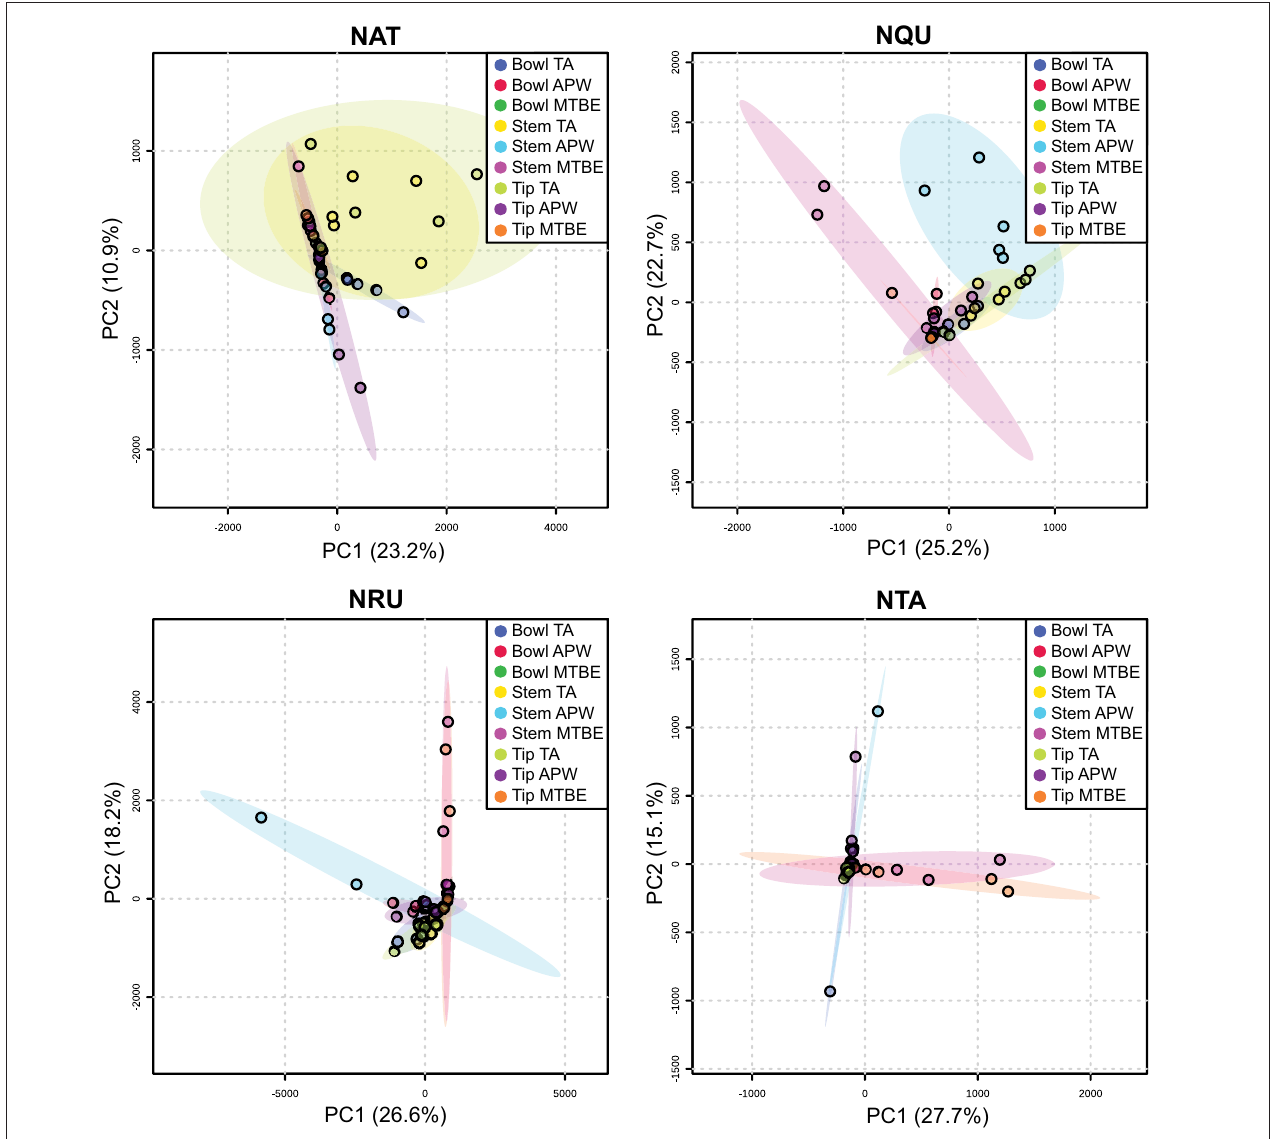
FIGURE 5 | Principal component analysis (PCA) of experimental pipes by section (i.e., bowl, stem, and tip) smoked with N. attenuata ( NAT ), N. quadrivalvis ( NQU ), N. rustica ( NRU ), and N. tabacum ( NTA ). TA, APW, and MTBE correspond to 2% aqueous tartaric acid, acetonitrile:2-propanol:water [3:2:2], and methyl tert -butyl ether, respectively. Each point within the 95% confidence regions represents five different pipe replicates ( n = 5).